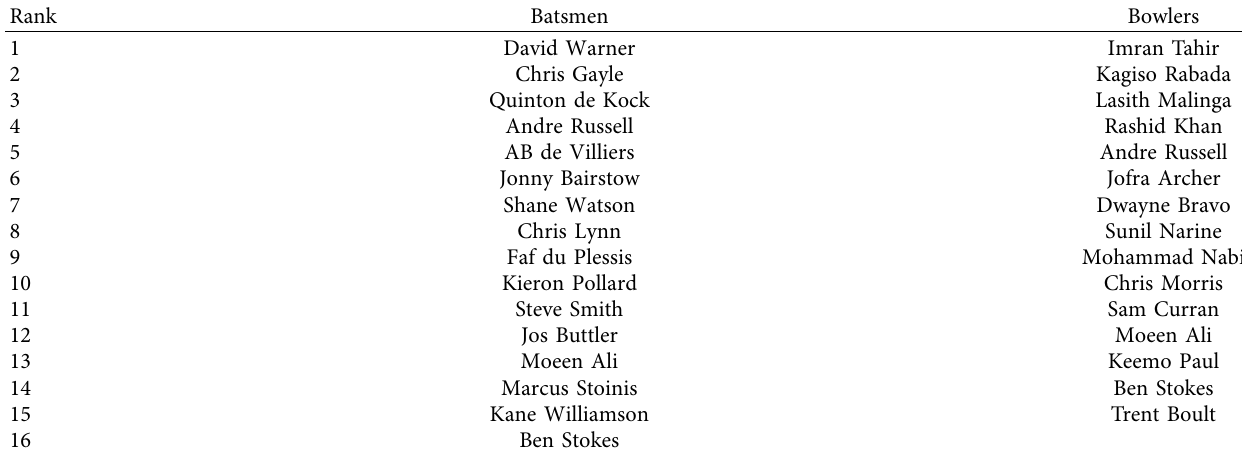
Table 13: Ranks generated by